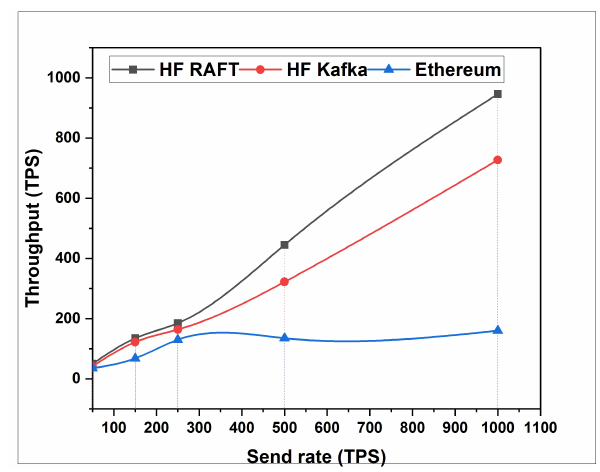
Figure 6. Throughput for Open.